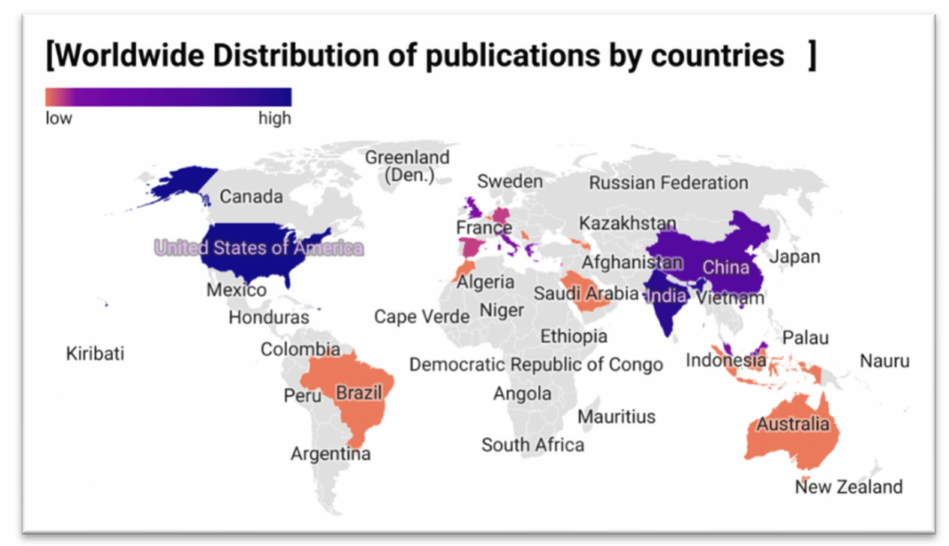
Figure 4. Chlorophet map showing the worldwide distribution of publications by